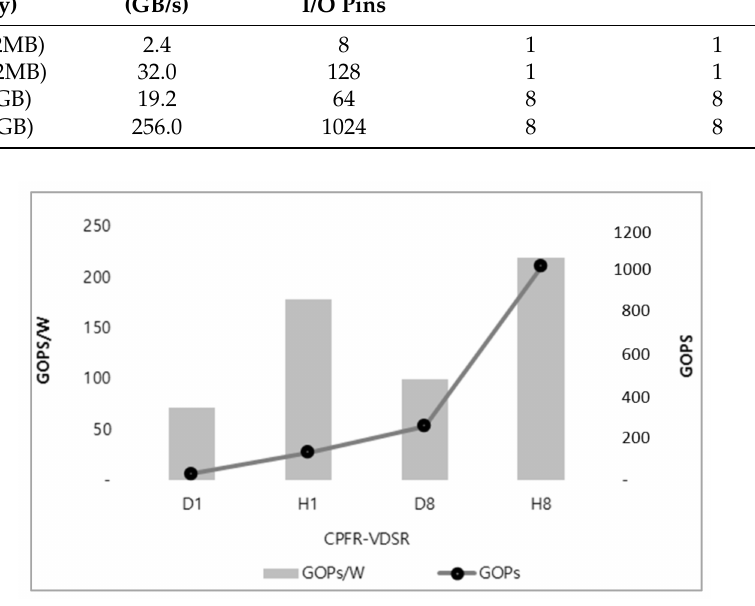
Figure 7. Efficiency (GOPS/W) and throughput (GOPS) comparison.